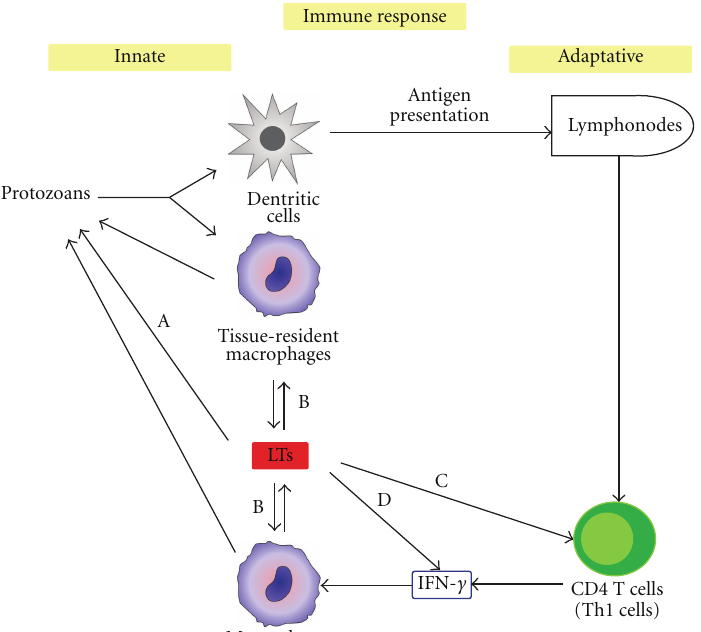
Figure 1: Modulation of innate and adaptive immune responses by LTs during the protozoan infections. Protective immunity against protozoans is mainly mediated by Th1 responses characterized by the production of inflammatory cytokines, such as IFN- γ , which activate macrophages to control of parasite replication. Macrophages are a source of LTs. (A) LTB 4 induces cytotoxicity in parasites. (B) LTB 4 and LTD 4 favored parasite killing by macrophages. (C) LTB 4 induces chemotaxis of CD4 + T cells. (D) LTB 4 induces the production of Th1 cytokines, such as IFN- γ